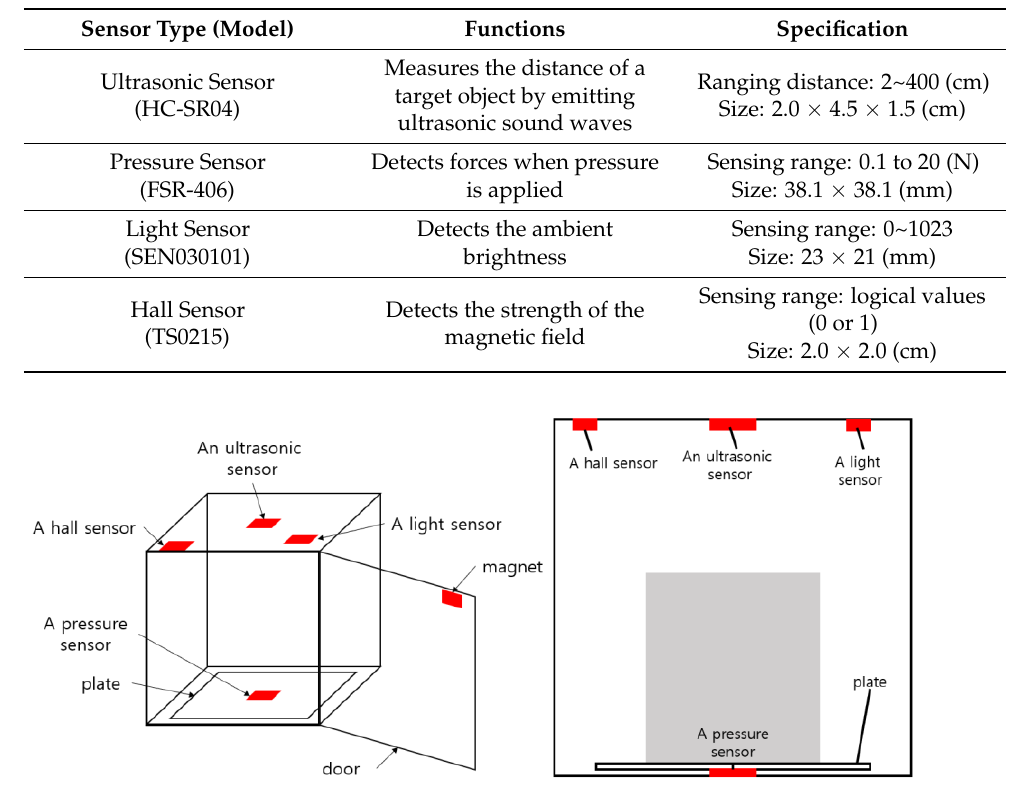
Figure 3. The deployment of the four sensors in the smart